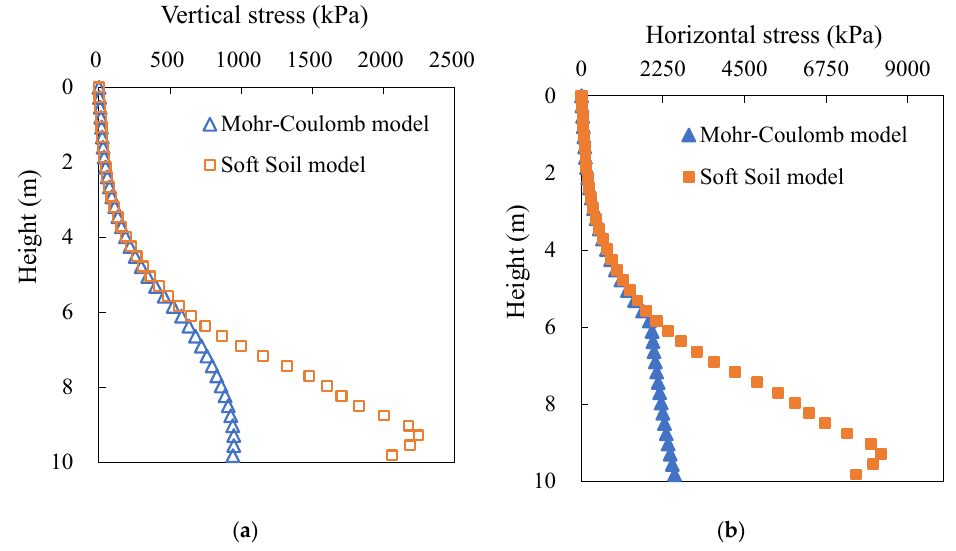
Figure 15. Variation of the ( a ) vertical and ( b ) horizontal stresses along the VCL of overlying backfill after excavating the underlying stope at a mine depth of 1000 m.